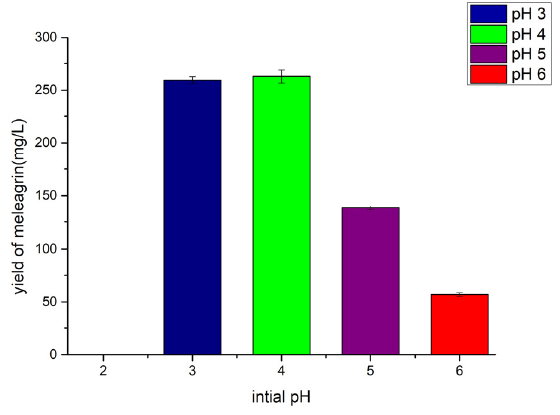
Figure 10. The yield of meleagrin under different pH.